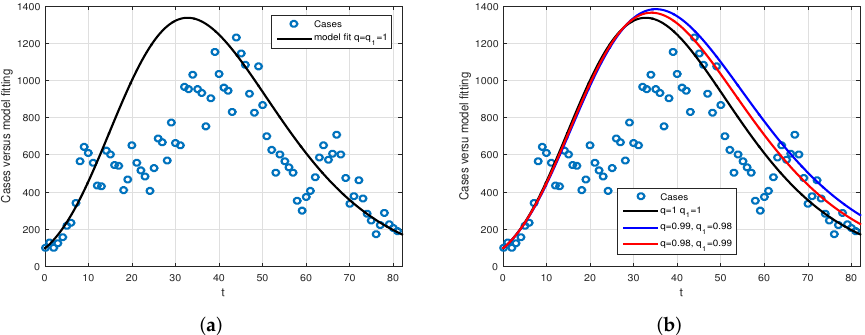
Figure 2. The data versus the model fitting for the cases 1 May–4 August 2022. The circle denotes real data while the bold curve denotes the model solution. Subfigure ( a ) represents the comparison of data versus model when q = q 1 = 1, while subfigure ( b ) is the comparison of data versus model for various values of q and q 1